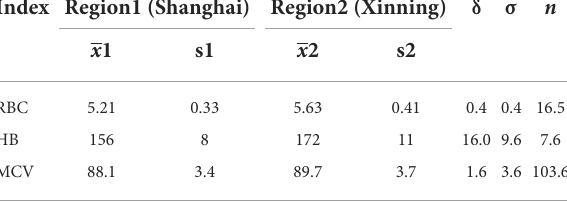
TABLE 1 Regional factors and minimum sample size.